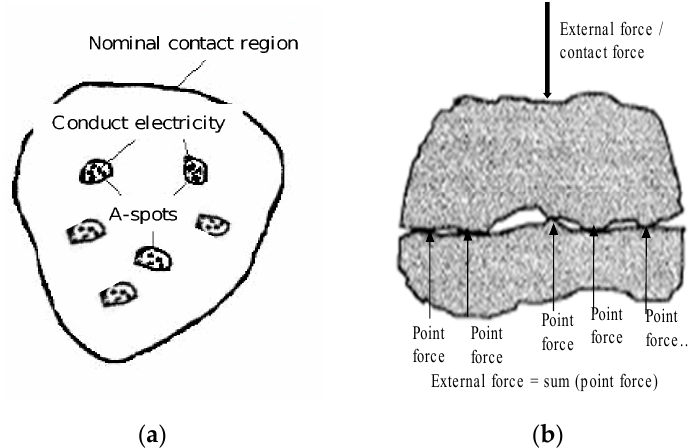
Figure 15. Real contact state. ( a ) Nominal contact region and conduct electricity spots; ( b ) Contacting status under equilibrium.